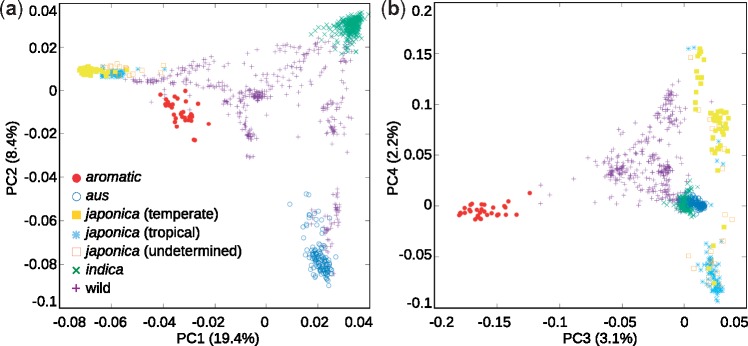
—PCA computed from the ∼2.4 million bialleleic sites in the merged data set. (a) The top two axes of variation jointly explaining 27.8% of the total variation. (b) The third and fourth axes jointly explaining 5.3% of the total variation.